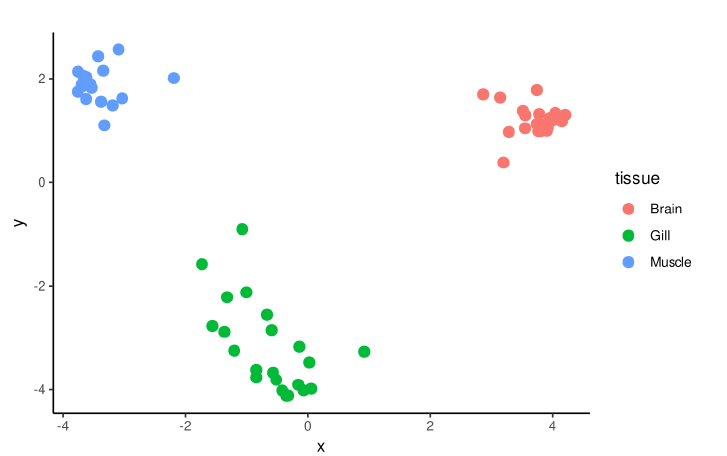
Figure 1. MDS plot obtained from expression data of all samples, excluding four outliers identified during the preliminary phases of analysis. Markers are colored by tissue of origin. Separate MDS plots are available for each of the three tissues in Figure